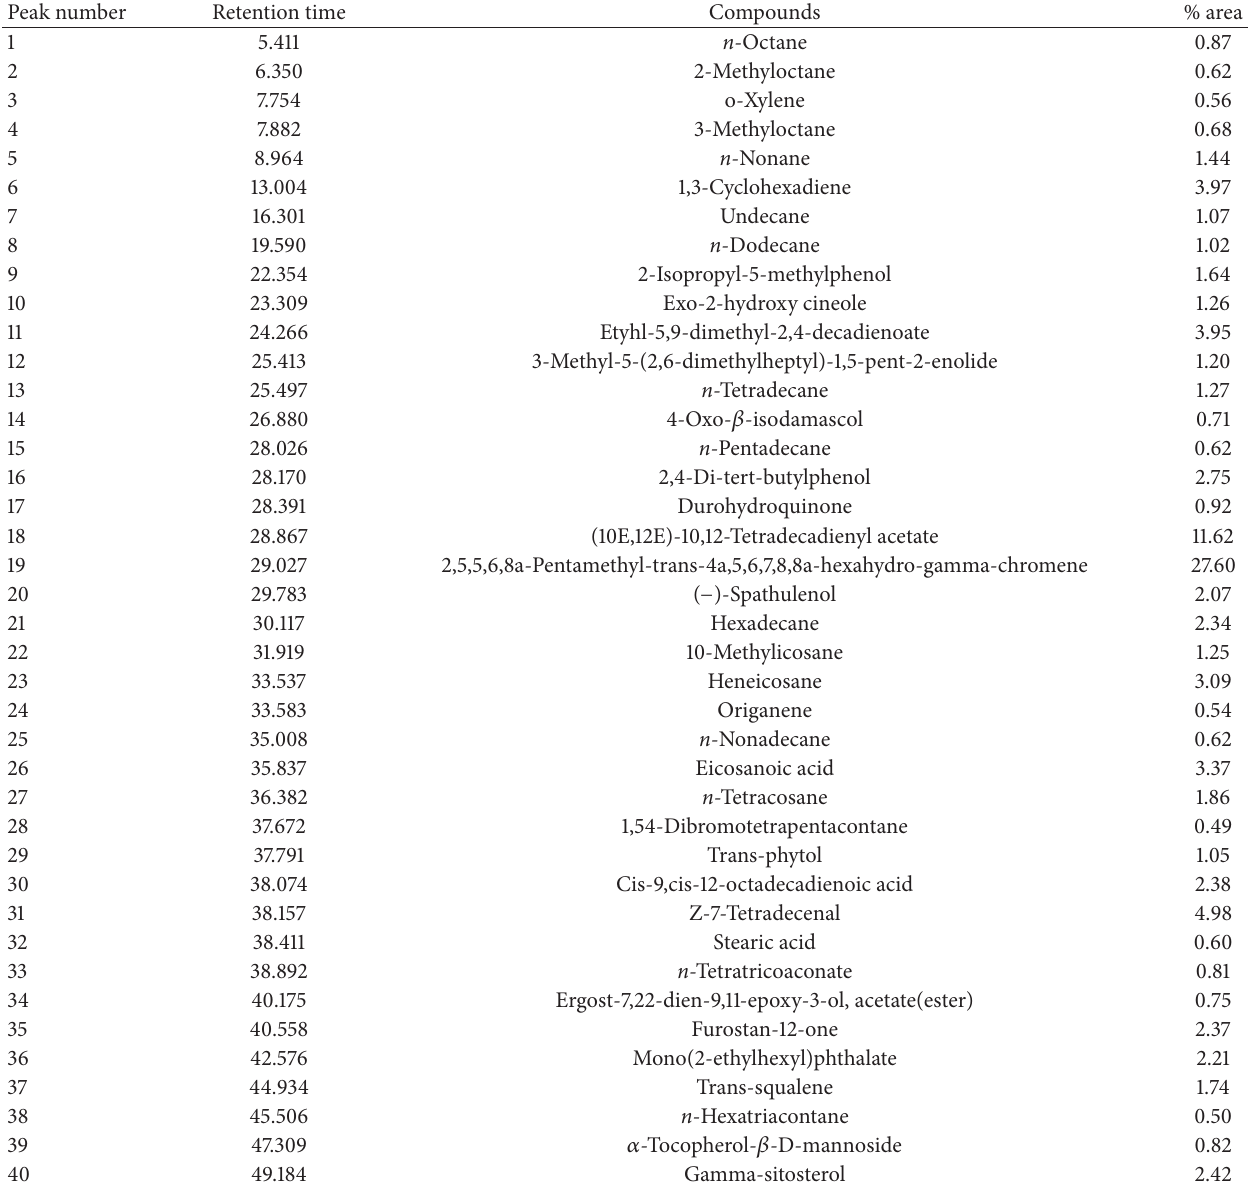
Table 3: GC-MS analysis of n -hexane extract of C. viminalis